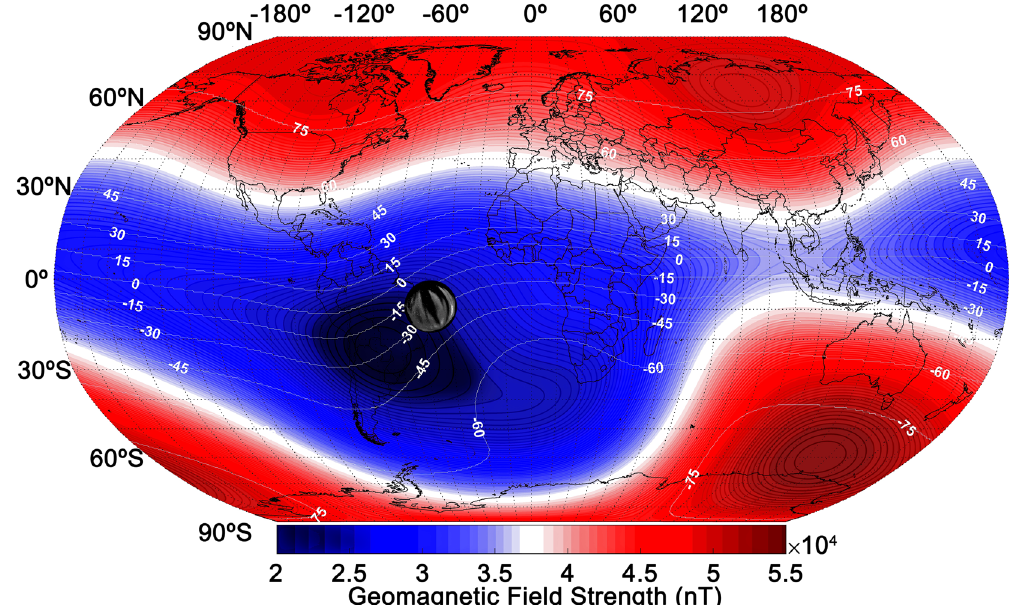
Fig. 1. Some of the phenomena which take place in the Brazilian region and affect the GPS performance. SAMA (darker blue region), and plasma bubbles (black striation in the